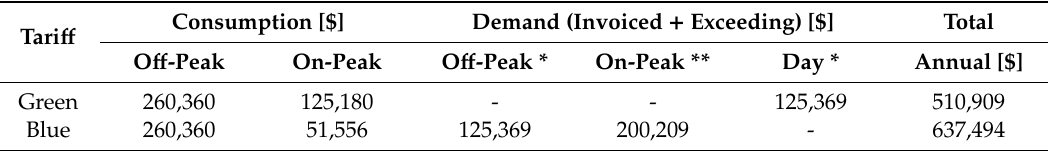
Table 12. Main results for Scenario 8.